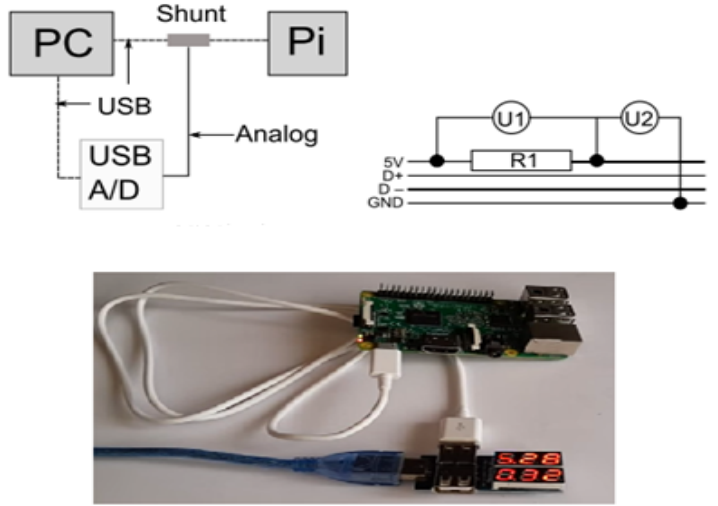
Figure 1. Raspberry power consumption measures.